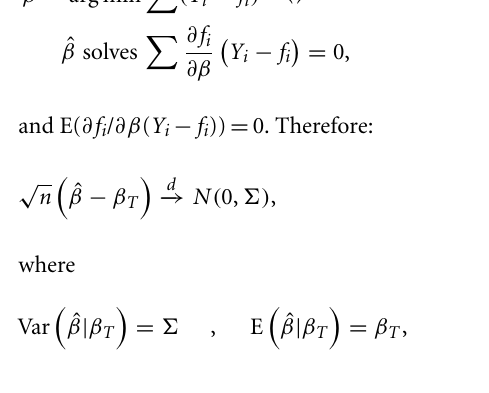
FIGURE 3 | Quantile-quantile plots of test statistics for each method, under H 0 with a MAF of 0.25 and equally spaced drug concentrations. Plots (A–F) represent the methods GenoCurve , ANOVA , IC 50, Slope , AUC emp ,